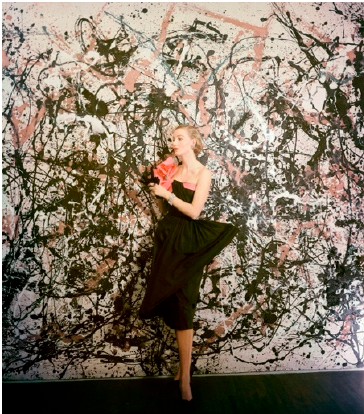
Figure 1. Cecil Beaton, The New Soft Look, 1951. Photographed against Pollock’s Autumn Rhythm at the Betty Parsons show in March, 1951. Courtesy Vogue © 1951 by The Condé Nast Publications.